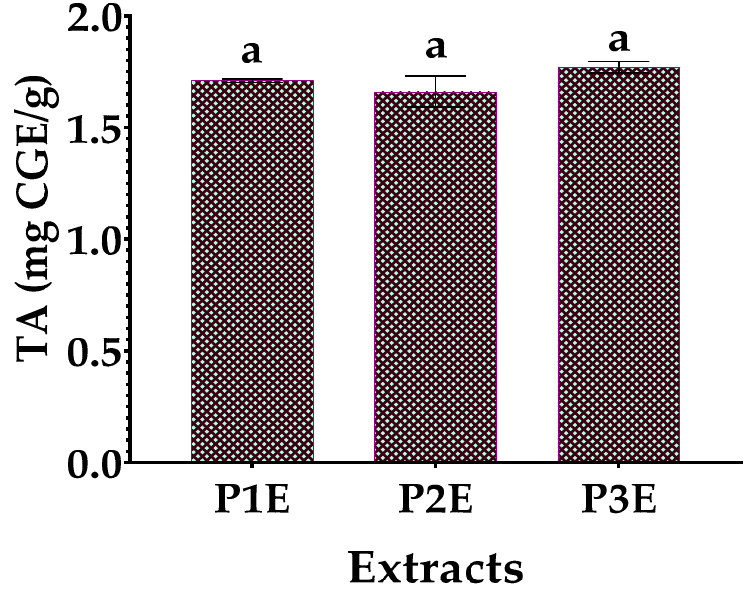
Figure 3. Anthocyanin content in the P. rhoeas extracts; CGE: cyanidin-3-glucoside chloride equiva- lents; a: the difference between the three samples was not significant ( p > 0.05).